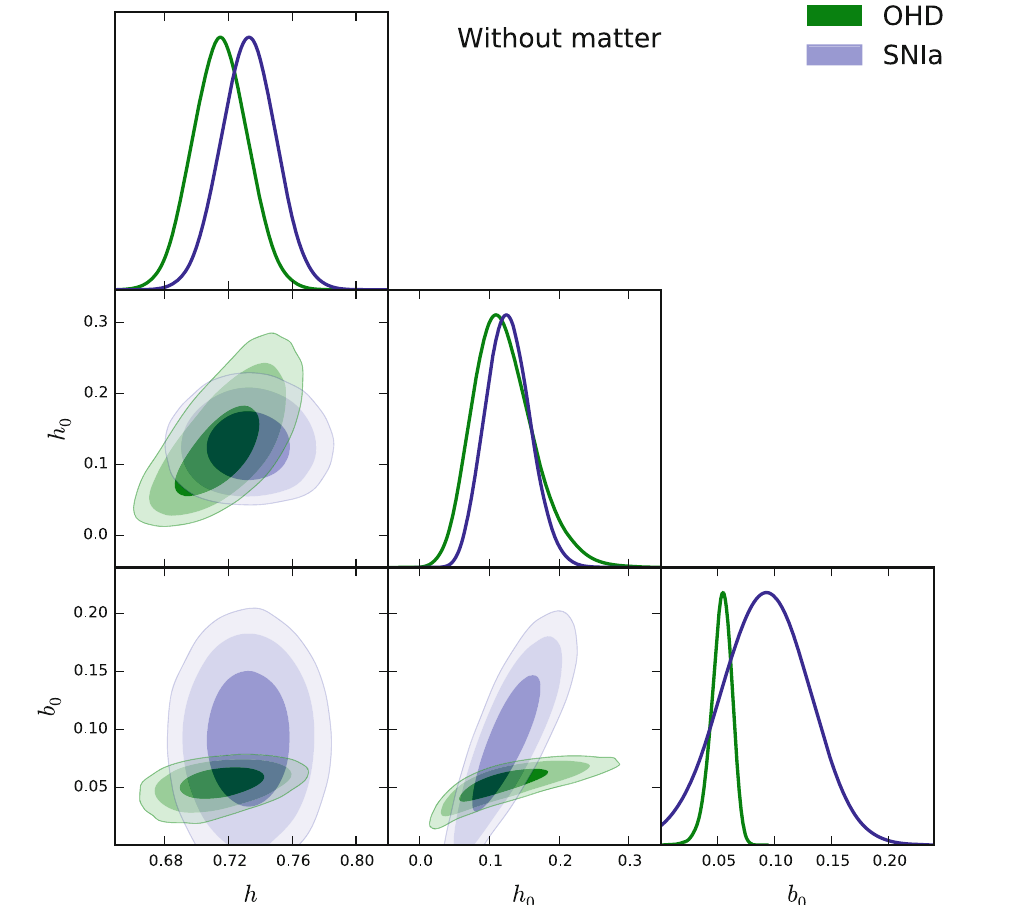
Fig. 10 1D marginalized posterior distributions and the 2D 68 , 95 , 99 . 7% confidence levels for the h , h 0 , and b 0 parameters of the NED